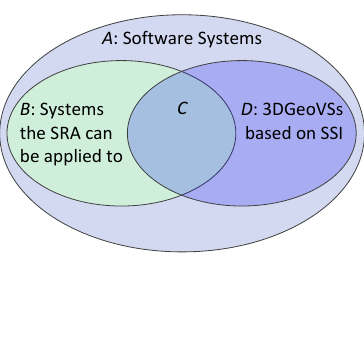
Figure 15. Sets of relevant